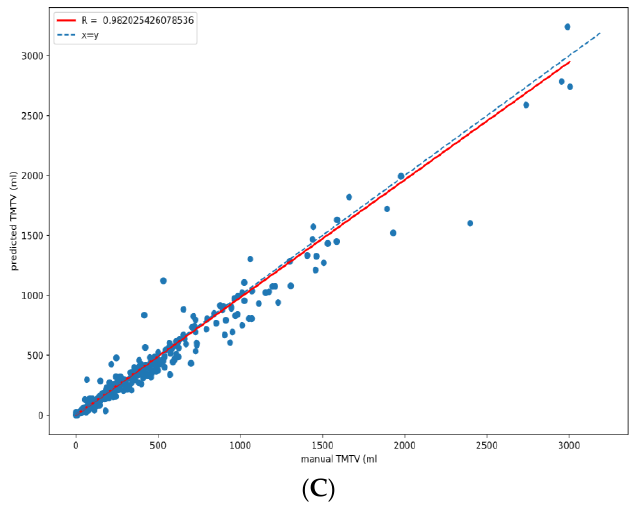
Figure 3. Correlation coefficient between the manual and predicted TMTV for each methodology ( A ) 41%, ( B ) 2.5, ( C ) 4.0.